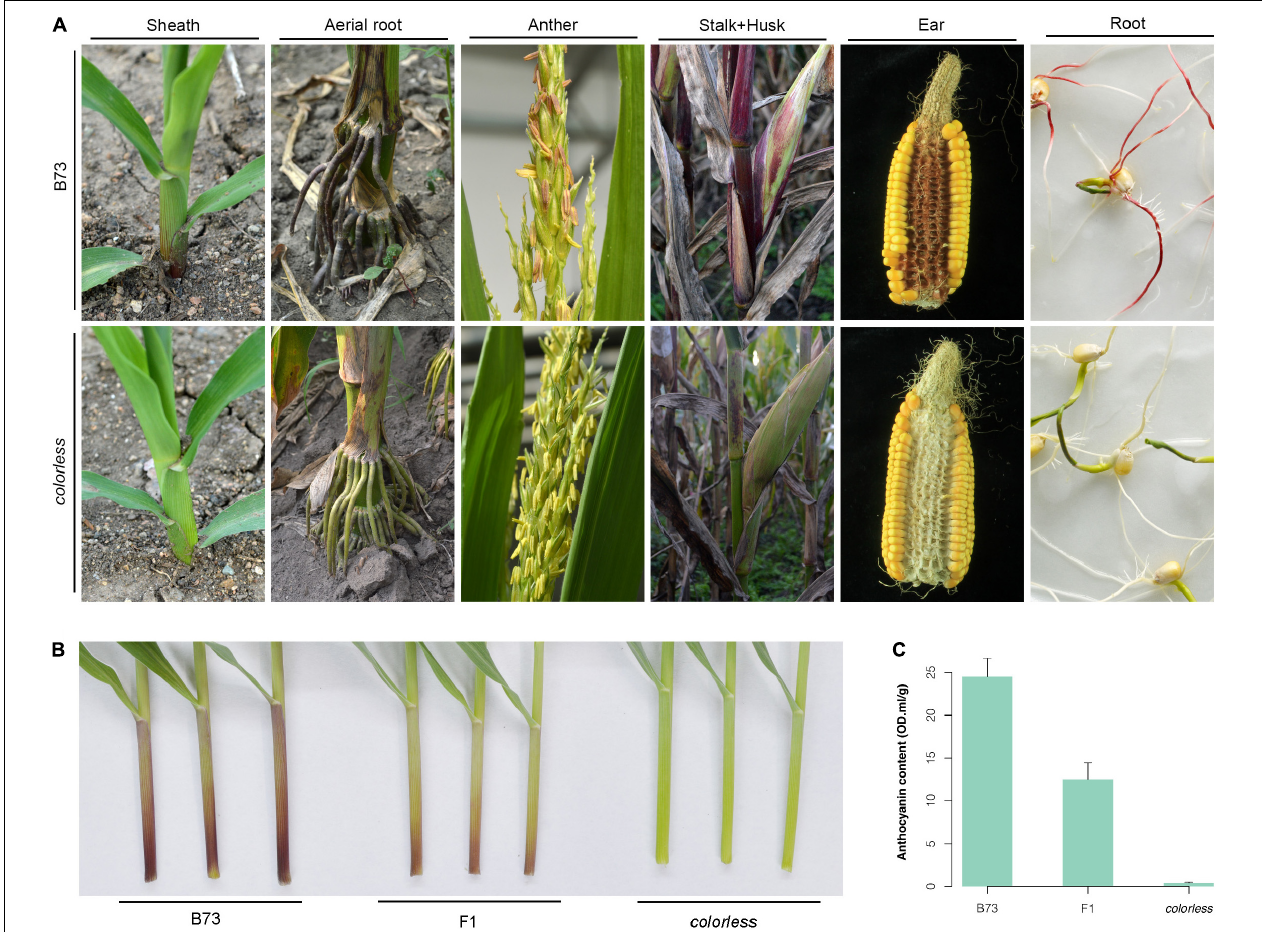
FIGURE 1 | Phenotypic observation of a colorless mutant. (A) Whole lifetime comparison of B73 and mutant. Sheath was observed at seedling stage; aerial root and anther, flowering stage; stalk and husk, late milk stage; ear, after harvest; root, germination of seeds under light. (B,C) Observation and anthocyanin content measurement of the first sheath of B73, mutant and their hybrid. Seedlings were grown in greenhouse to three-leaf stage. Error bars indicate standard deviation (SD) of over three biological replicates.